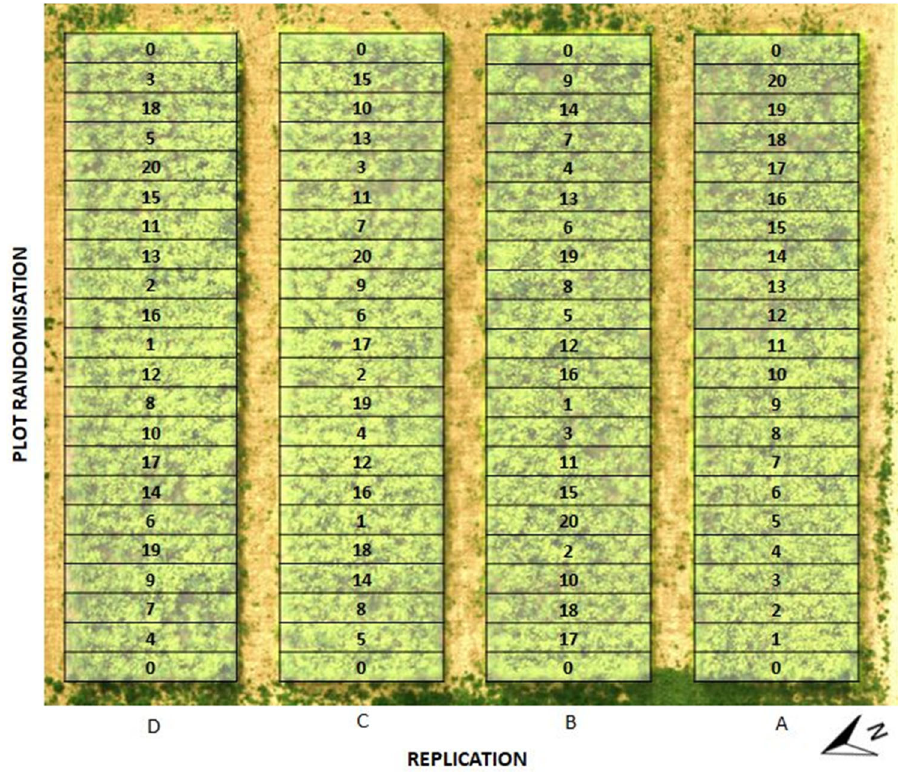
Figure 2. Randomization of 20 experimental variants in four replications.